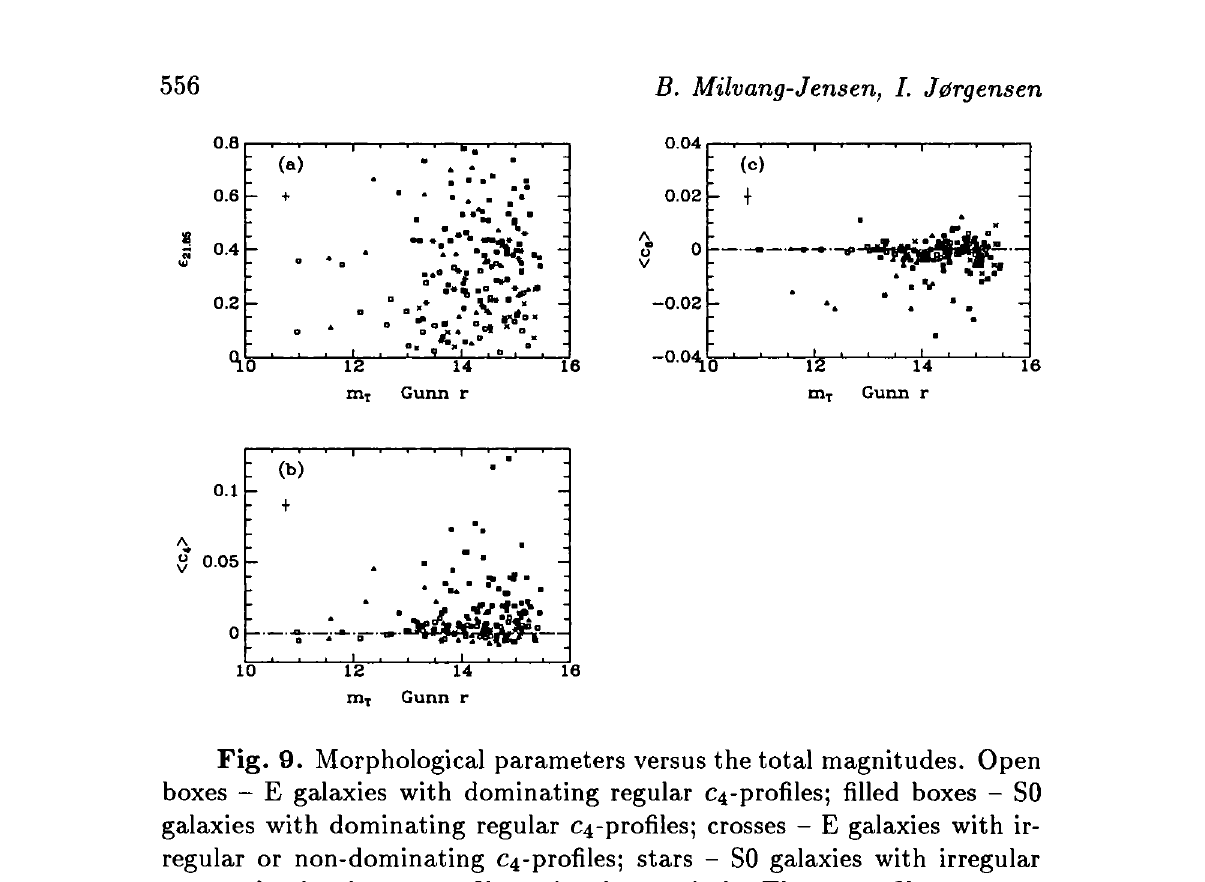
Fig. 9. Morphological parameters versus the total magnitudes. Open boxes - E galaxies with dominating regular C4 -profiles; filled boxes - SO galaxies with dominating regular C4 -profiles; crosses - E galaxies with ir- regular or non-dominating C4 -profiles; stars - SO galaxies with irregular or non-dominating C4 -profiles; triangles - spirals. The C4 -profiles are con- sidered non-dominating if | {C4) | is more than one sigma smaller than the absolute value of one of the other intensity weighted mean coefficients. Typical measurement errors are given on the panels. Galaxies with un- certainty on C4 respectively (04) larger than 0.02 are not plotted. The six brightest galaxies have small Fourier coefficients and €21.85 < 0.4. Other dependence on mT is not seen. (From